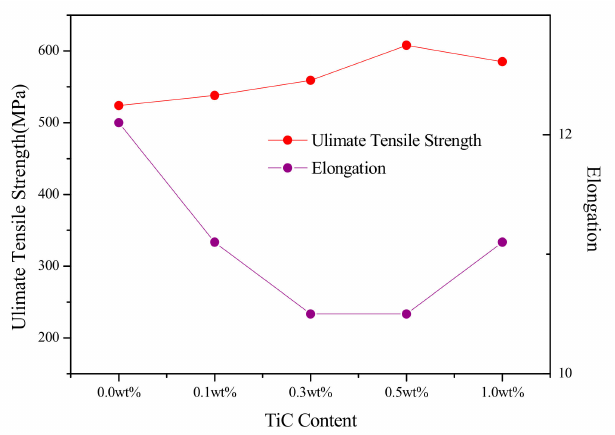
Figure 12. Mechanical properties of 7085 alloy with di ff erent TiC